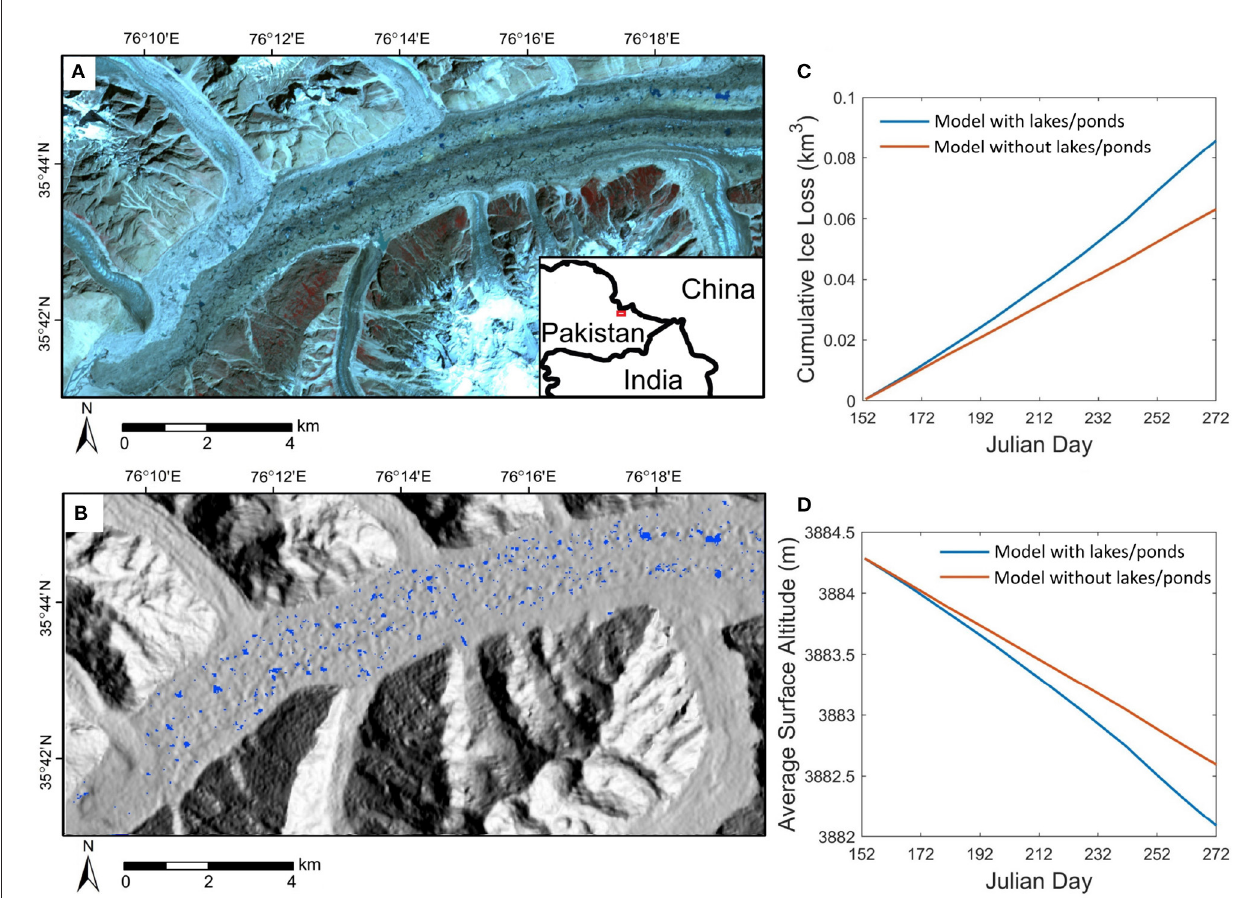
FIGURE 8 | (A) ASTER false-color composite imagery (VNIR bands) of the lower ablation zone of the Baltoro Glacier acquired on August 14, 2004. (B) A large number of supraglacial ponds and lakes mapped from the satellite data using the normalized difference water index. (C) Temporal variation in the simulated cumulative ice-volume loss for this area over the ablation season of 2004. Two scenarios (with and without lakes/ponds) are compared. (D) Comparison of the mean surface altitude variations for the two simulations. Note the increased non-linearity in ice loss and surface lowering when supraglacial lakes/ponds are present.